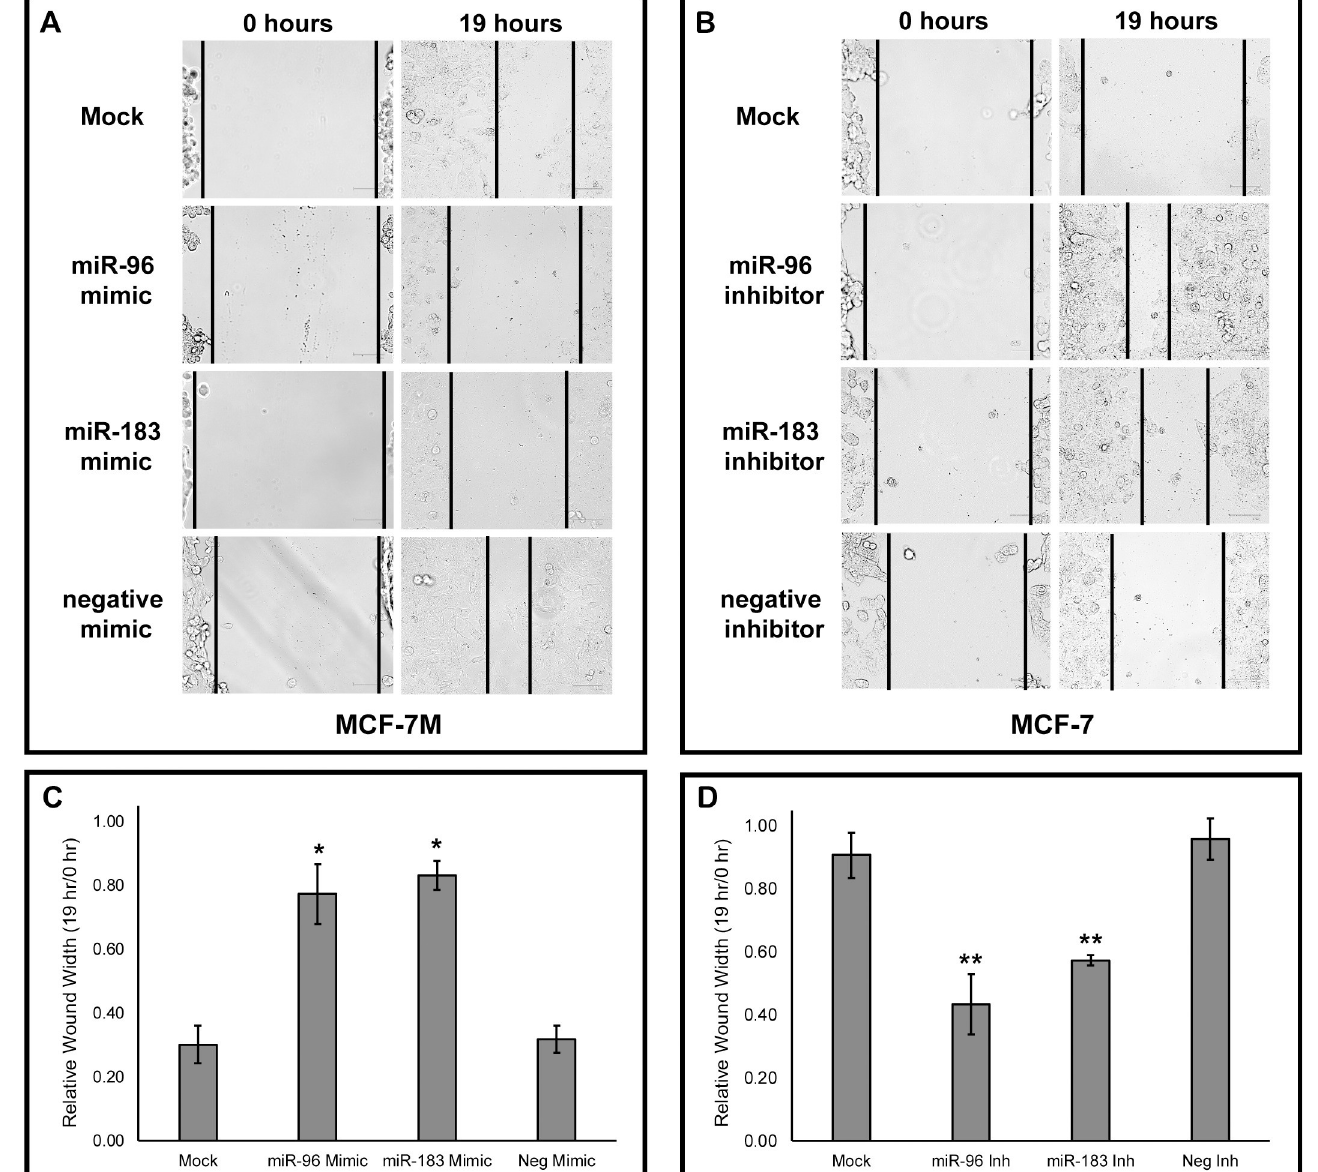
Fig 2. MicroRNAs miR-96 and miR-183 regulate cell migration. (A) 50 nM of mirVana ™ miRNA mimics for miR-96, miR-183, or Negative Control #1 were transfected into MCF-7 M cells and (B) 50 nM of mirVana ™ miRNA inhibitors for miR-96, miR-183, or Negative Control #1 were transfected into MCF-7 cells. Cells were allowed to grow for 24 hours post-transfection before each well was scraped in triplicate with a p-10 pipette tip. Images of wounds were taken using the EVOS FLoid Cell Imaging Station and are representative of three independent transfections. (C, D) Relative wound width was determined using ImageJ software (length of wound at 19 hours divided by length of wound at 0 hours) for MCF-7 M cells treated with miRNA mimics and MCF-7 cells treated with miRNA inhibitors (Inh). Values expressed as averages ± SEM. � p < .05, �� p < .01. https://doi.org/10.1371/journal.pone.0233187.g002 proliferation and migration, however whether these microRNAs promote or inhibit these pro- cesses is unclear and seems to be context dependent [7]. Therefore, we used a pre- and post- EMT breast cancer cell culture model [6] to determine the role of the miR-183-96-182 cluster in regulating cell growth and migration. In our cell culture model, miR-96 and miR-183 (but not miR-182) were found to be downregulated in the post-EMT MCF-7 cells (Fig 1). Due to M